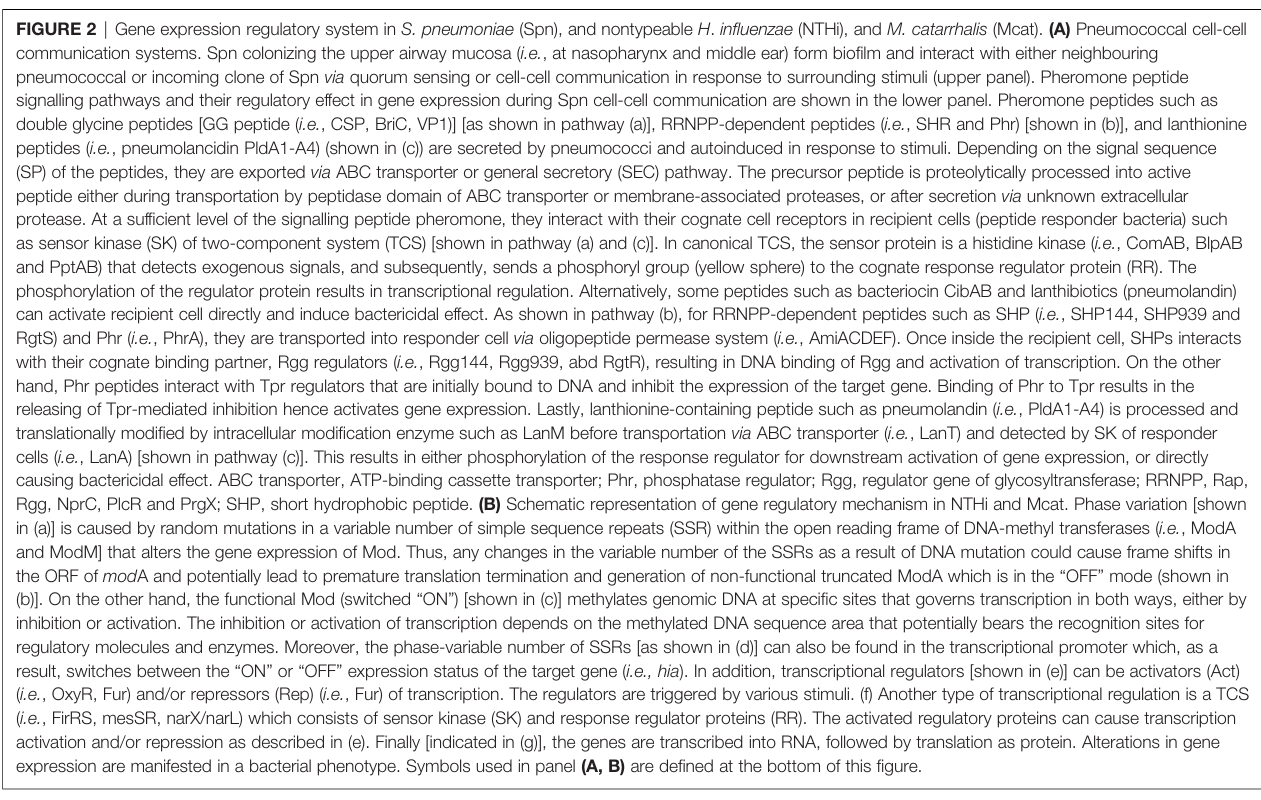
FIGURE 2 | Gene expression regulatory system in S. pneumoniae (Spn), and nontypeable H . in fl uenzae (NTHi), and M. catarrhalis (Mcat). (A) Pneumococcal cell-cell communication systems. Spn colonizing the upper airway mucosa ( i.e. , at nasopharynx and middle ear) form bio fi lm and interact with either neighbouring pneumococcal or incoming clone of Spn via quorum sensing or cell-cell communication in response to surrounding stimuli (upper panel). Pheromone peptide signalling pathways and their regulatory effect in gene expression during Spn cell-cell communication are shown in the lower panel. Pheromone peptides such as double glycine peptides [GG peptide ( i.e. , CSP, BriC, VP1)] [as shown in pathway (a)], RRNPP-dependent peptides ( i.e. , SHR and Phr) [shown in (b)], and lanthionine peptides ( i.e. , pneumolancidin PldA1-A4) (shown in (c)) are secreted by pneumococci and autoinduced in response to stimuli. Depending on the signal